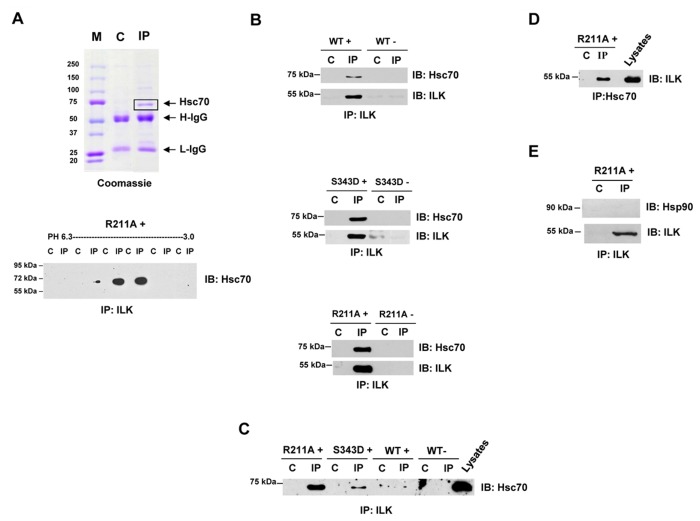
ILK forms a complex with Hsc70.
A, (upper panel) SDS gel of ILK immunoprecipitates (IP) stained with Coomassie brilliant blue identified a major band at the size of 70 kD, which was confirmed by mass spectrometry as the mouse orthologue of heat-shock cognate protein 70 (Hsc70, also known as Hsp73). IP of ILKR211A binds specifically to Hsc70 in 2D Isoelectric Focused (IEF)/SDS gel (lower panel). Myocardial lysates obtained from TgR211A hearts were immunoprecipitated using anti ILK rabbit Ab (IP) and control rabbit IgG (C) and then loaded into wells of an (IEF; pH 3.0-6.3) gel. ILK IP and C lanes were cut and inserted into wells of SDS gel, transferred and stained in Western blot using anti-Hsc70 goat Ab. B, ILK IPs derived from myocardial lysates of transgenic mice with cardiac-specific over-expression of ILK wild type (WT+), constitutively-active (S343D+) or activation resistant R211A+ mutations and their littermate controls (WT-, S343D- and R211A-) were probed with anti-Hsc70 antibodies. C, Western blot analysis demonstrating ILK IPs derived from myocardial lysates of transgenic mice showing gradient binding of ILK with Hsc70 which was the highest in R211A+, intermediate in S343D+, and lowest in WT+. D, Reciprocal analysis showing ILK binding in Hsc70 IP. E, ILK does not Co-IP with Hsp90. Co-IPs was performed in triplicate on independent samples and representative blots are shown.